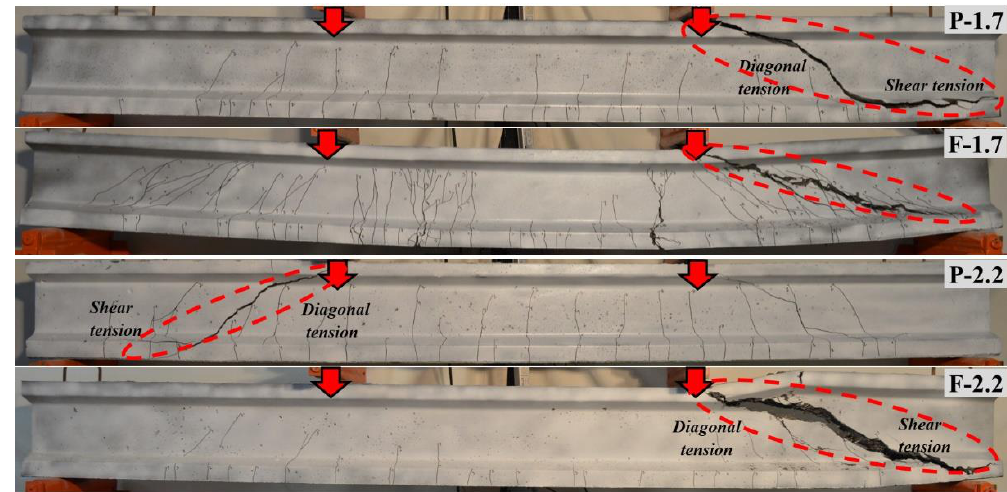
Figure 8. Comparison of failure modes for the test beams with high reinforcement ratios.